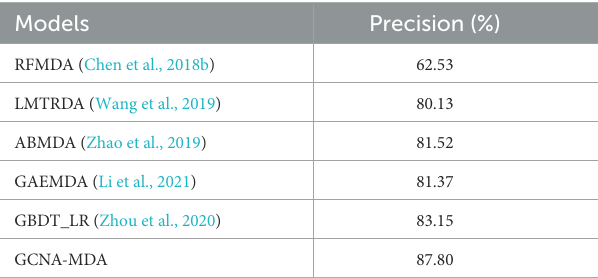
TABLE 1 Precision of six methods in miRNA-disease classification